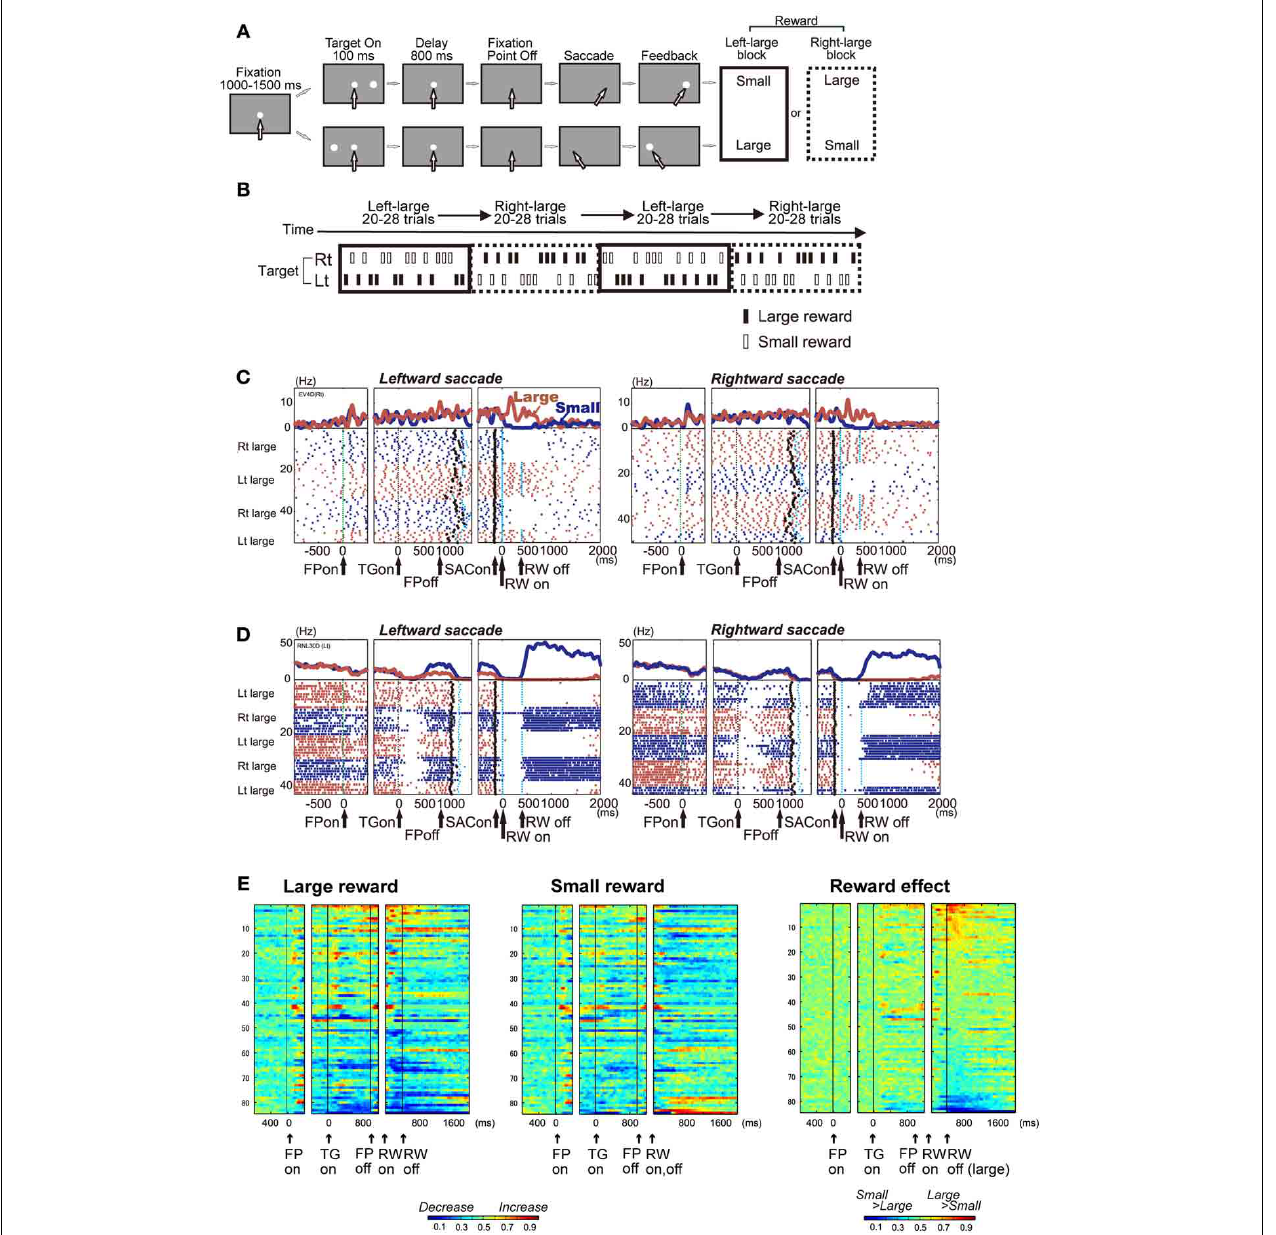
FIGURE 2 | (A) One direction rewarded memory guided saccade (1DR-MGS) task. After the monkey fixated on the central fixation point for 1200ms, one of the two target positions was flashed for 100ms. After the fixation point disappeared, the monkey made a saccade to the cued position to receive a liquid reward. The white arrows indicate the direction of gaze. In a block of 20–28 trials (e.g., left-large block), one target position (e.g., left) was associated with a large reward and the other position (e.g., right) was associated with a small reward. The position-reward contingency was then reversed (e.g., right-large block). (B) Left-large and right-large conditions were alternated between blocks with no external cue. The location of the target was determined pseudo-randomly. (C,D) Examples of the activity of two DRN neurons in the 1DR-MGS task. The activity in the large- and small-reward trials is shown in red and blue, respectively. The histograms and raster plots are shown in three sections: the left section is aligned to the time of fixation point onset (FPon), the middle section is aligned to target onset (TGon) and fixation point offset (FPoff), and the right section is aligned to reward onset (RWon).